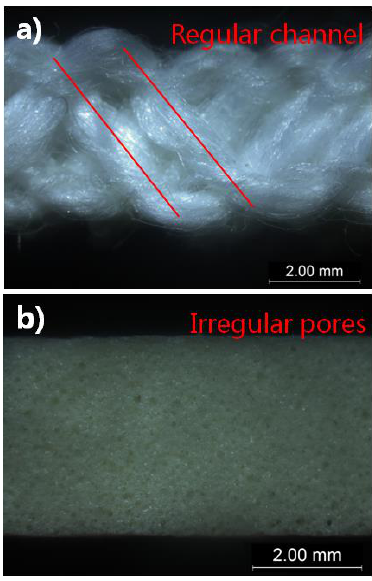
Figure 9. Light microscope pictures of cross-section of ( a ) superabsorbent spacer fabric, and ( b ) foam dressing.